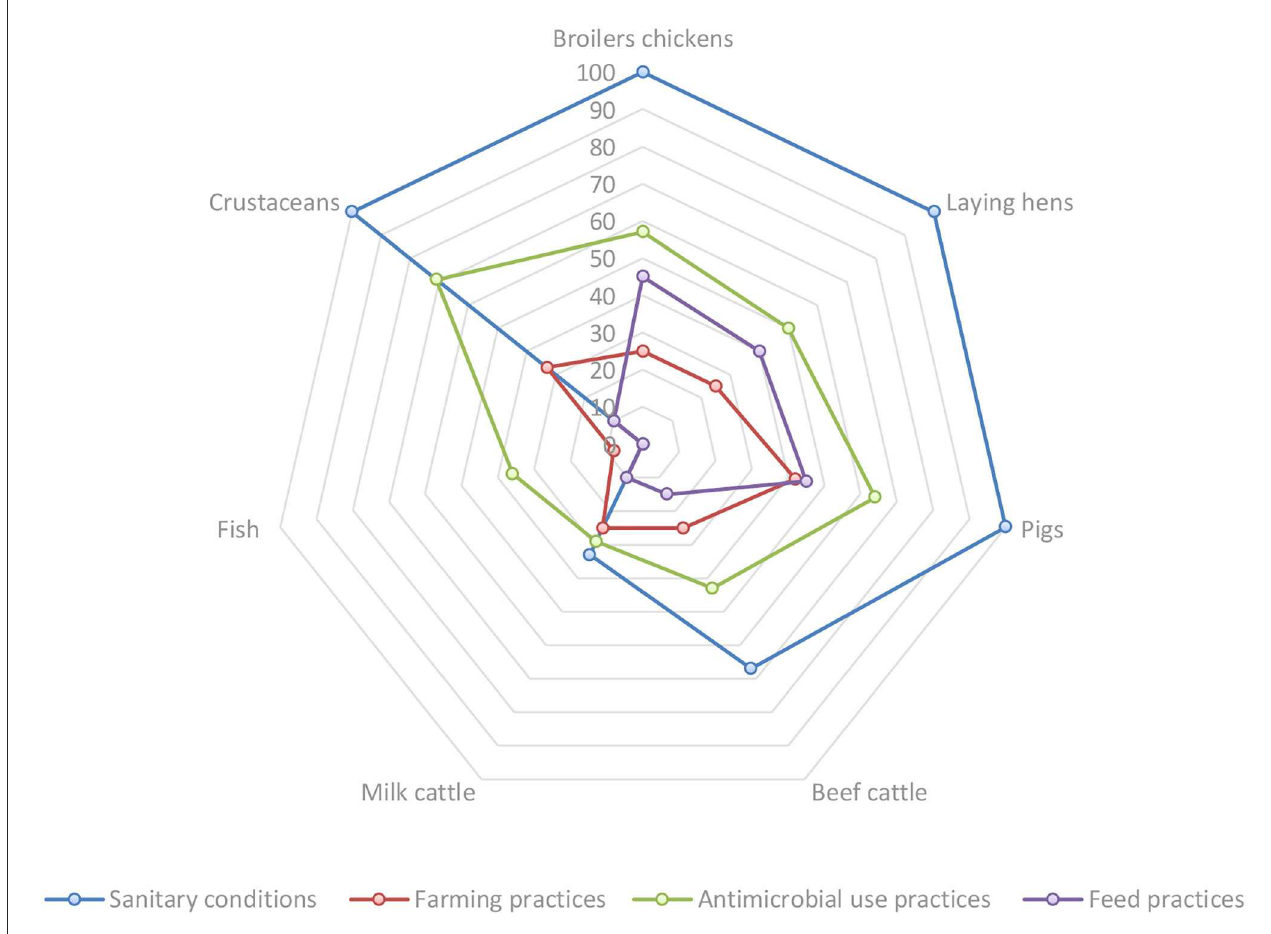
FIGURE4 Comparative percentages of subfactors that present risks based on the qualitative risk assessment for animal health, by introduction risk factors and animal production systems.